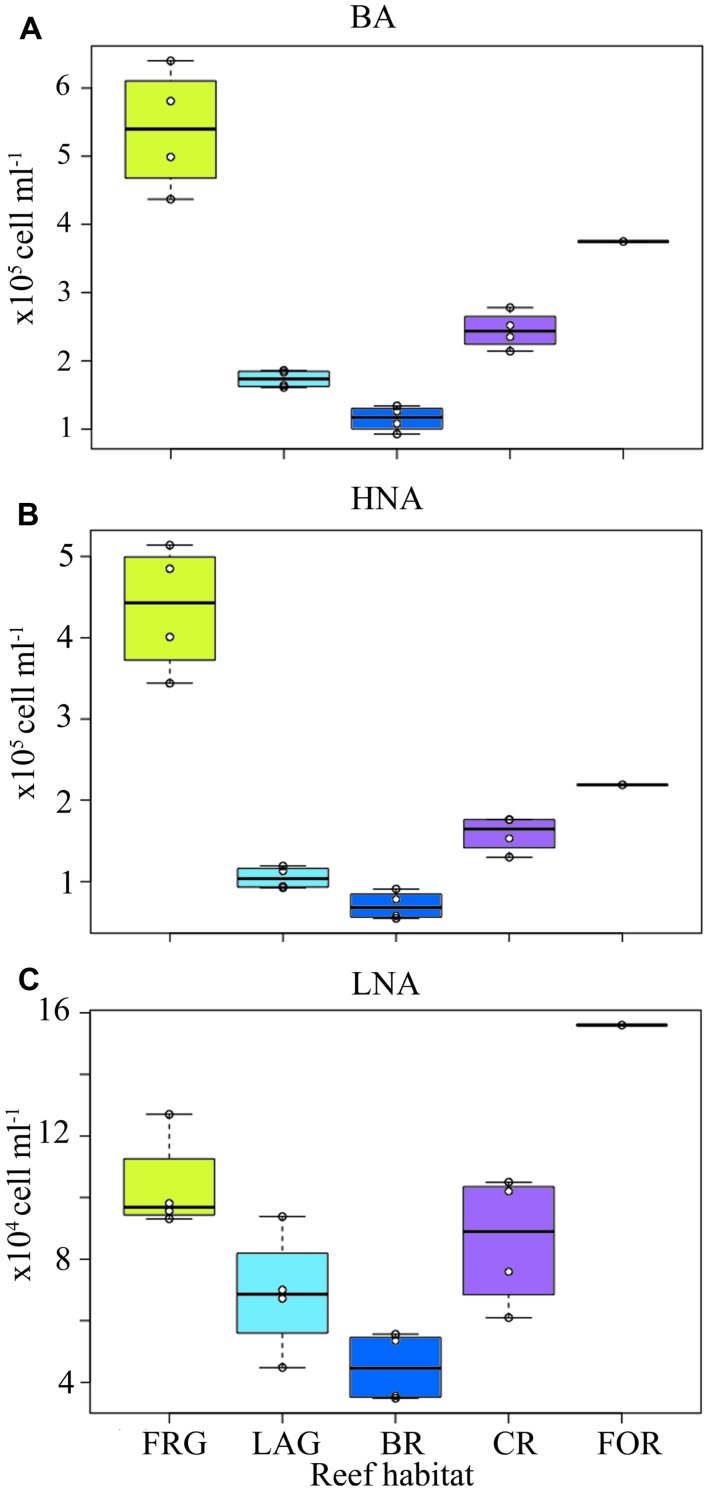
Spatial distribution of heterotrophic bacteria across the fringing reef (FRG), lagoon (LAG), back reef (BR), crest (CR), and fore reef (FOR) habitats. (A) Heterotrophic bacterial abundance (BA), (B) high nucleic acid (HNA) bacterial abundance and (C) low nucleic acid (LNA) bacterial abundance. Note the FOR was sampled only once on the north transect. Boxplots represent 50th (median), 75th and 25th percentiles. Circles represent mean values of duplicate samples collected for each transect.